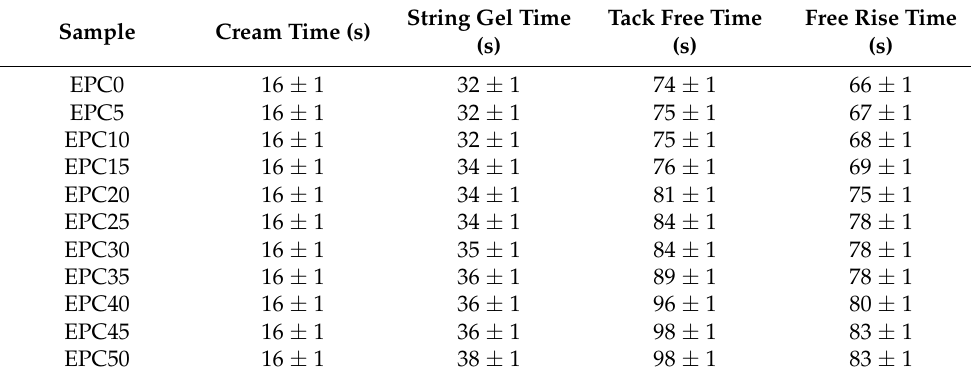
Table 1. Processing times of obtained RPU/PIR